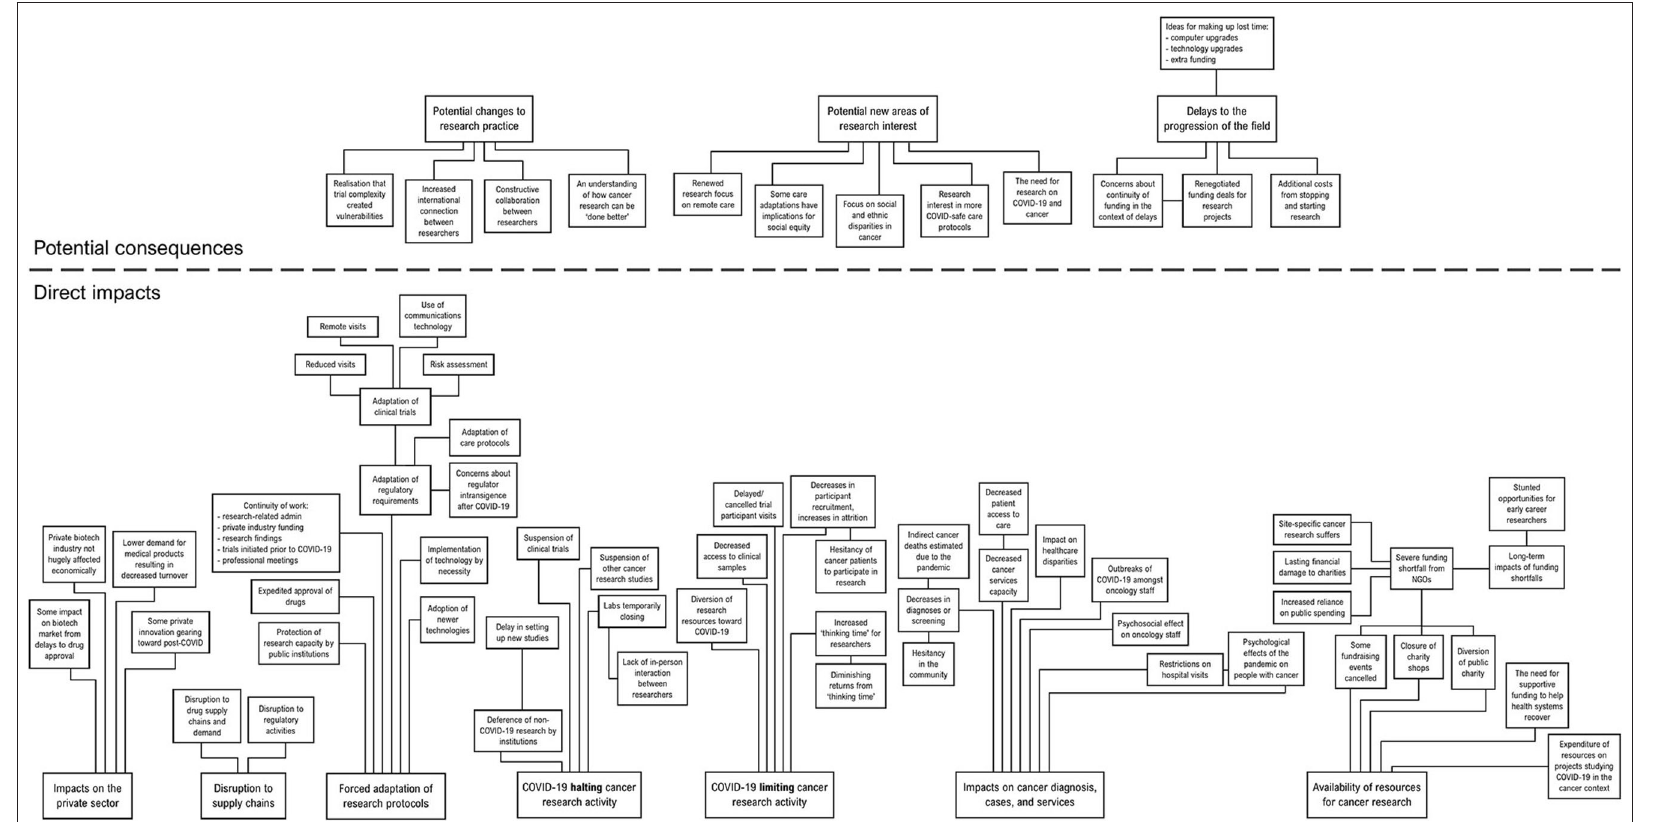
FIGURE 1 | A conceptual mind map of the categories produced by the content analysis, with their